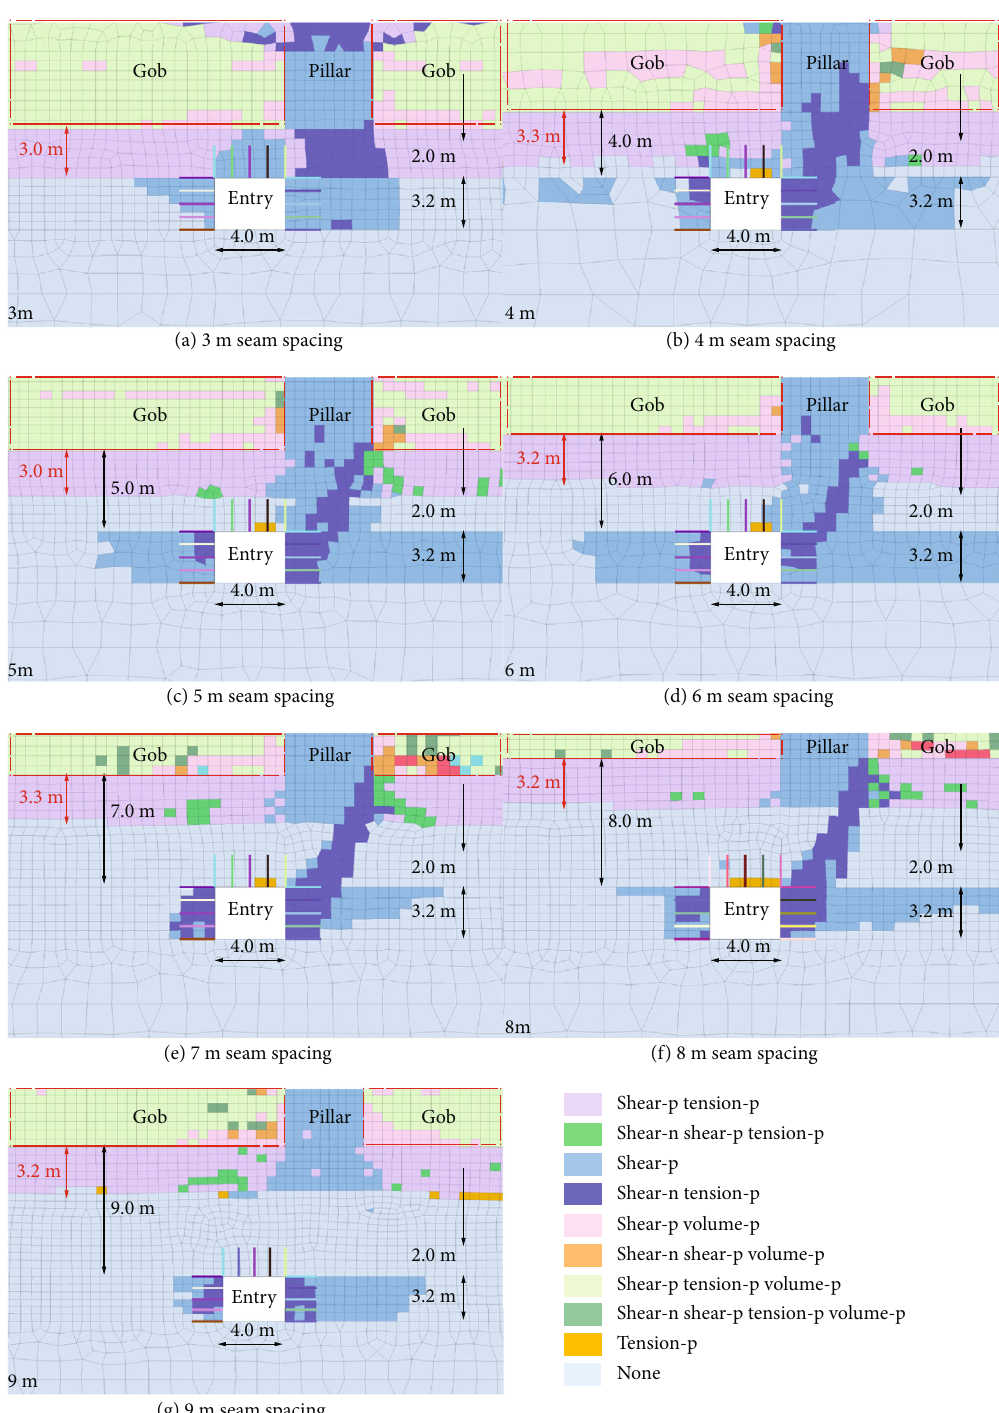
Figure 10: Yield zone distributions around entry for di ff erent seam